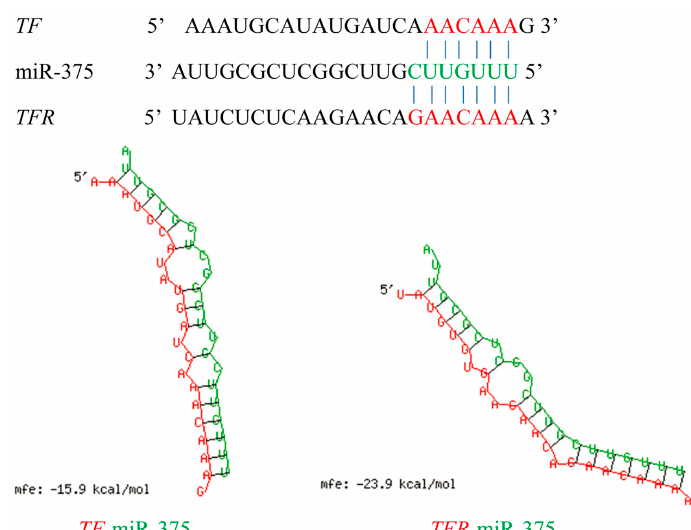
Figure 7. The predicted binding sites of miR-375 to transferrin ( TF ) and transferrin receptor ( TFR ) genes. The sequences of gene ( TF and TFR ) and miR-375 are shown in red and green, respectively.